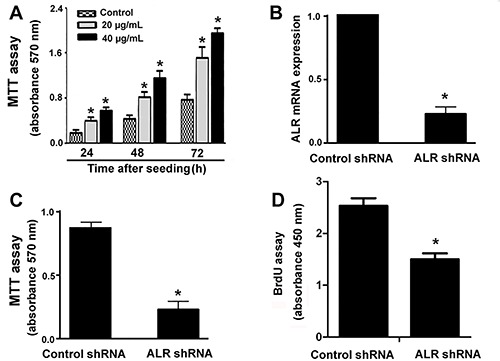
Augmenter of liver regeneration (ALR) regulated the proliferation of U266 multiple myeloma (MM) cells. A, U266 MM cells were exposed to 20 or 40 μg/mL recombinant ALR protein for 24-72 h and cell viability was examined by the MTT assay. ALR treatment significantly promoted the proliferation of U266 MM cells. *P<0.05 vs untreated control cells; n=6 (one-way ANOVA with the Tukey test). B, qRT-PCR analysis of the ALR mRNA level in U266 cells transfected with control or ALR shRNA; n=3. C, MTT assay was done to measure the viability of U266 cells transfected with control or ALR shRNA after culturing for 72 h; n=6. D, Cell proliferation was determined by BrdU incorporation assay after culturing for 72 h. ALR silencing significantly suppressed the proliferation of U266 MM cells. *P<0.05 vs the control shRNA group; n=6 (Student t-test).